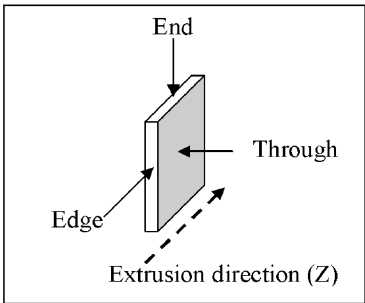
Figure 3. Directions of incident X-ray beams with respect to the extrusion direction. X and Y define the plane of the film and Z corresponds to the extrusion directions.